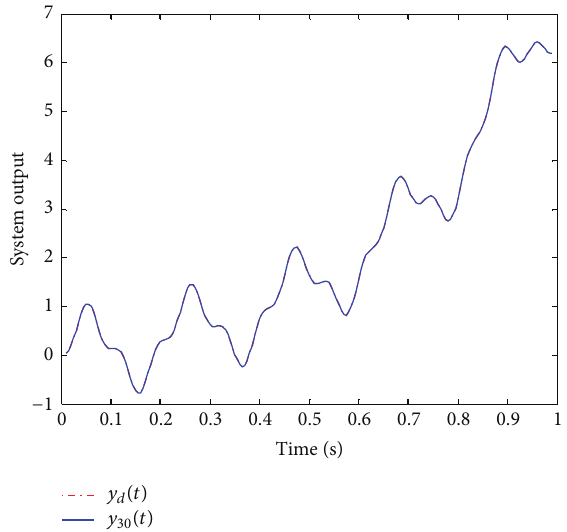
Figure 2: System output trajectory at 5th iteration for Example 1.